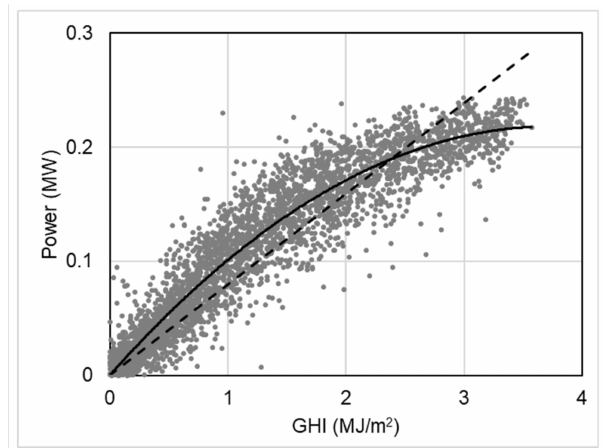
Figure 2. The scatterplot between the PV power output and the global horizontal irradiance (GHI; Jeollanam-do, Youngkwang-gun, 300